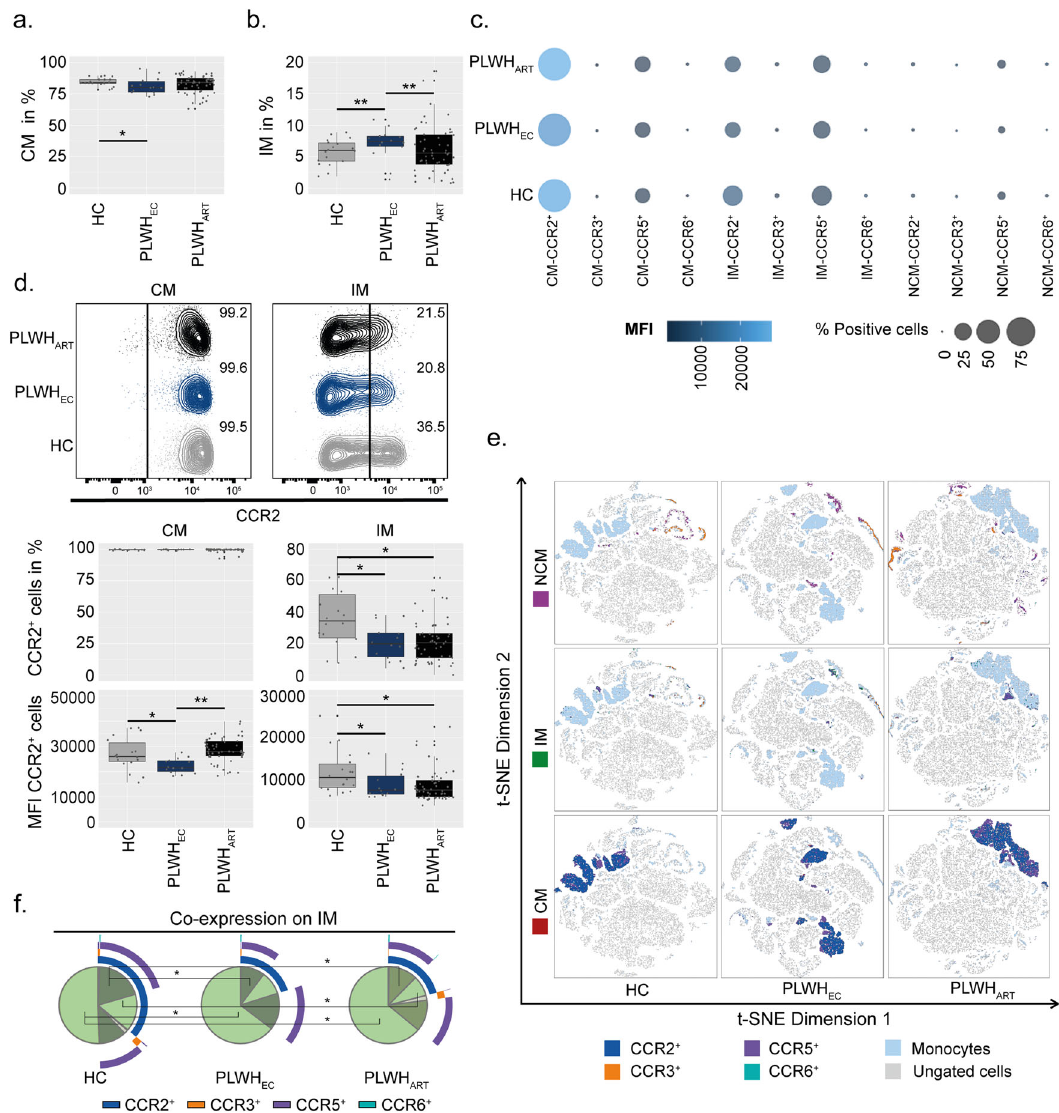
Fig. 2 CCR2 is depleted from intermediate monocytes of PLWH. Receptor expression on monocytic subpopulations (classical monocytes (CM); CD14 + CD16 − , intermediate monocytes (IM) CD14 + CD16 + and non-classical monocytes (NCM); CD14 − CD16 + ) in PLWH EC ( n = 14), PLWH ART ( n = 54) and HC ( n = 18). a , b Percentages of CM ( a ) and IM ( b ) from CD3 − cells in peripheral blood mononuclear cells. c Bubble chart representing receptor expression of CCR2, CCR3, CCR5 and CCR6 on CM, IM and NCM. Size of the bubble corresponds to percentage-positive cells while colour represents the median fl uorescent intensity (MFI). d CCR2 receptor expression on CM and IM (% cells and MFI). e t-SNE plots showing receptor expression distribution of CCR2, CCR3, CCR5 and CCR6 on CM, IM and NCM. f Co-receptor expression of CCR2, CCR3, CCR5 and CCR6 on IM. d Contour plot shows a representing sample from PLWH EC , PLWH ART and HC corresponding to the median % of cells within each group. a , b , d , f Statistical signi fi cance was determined using two-tailed Mann – Whitney U-test (signi fi cance level p < 0.05, with *<0.05, **<0.001) and represented as pie charts or with median using 95%